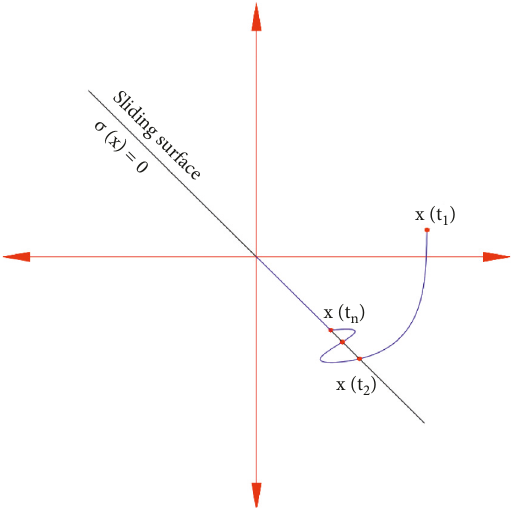
Figure 2: Sliding surface.